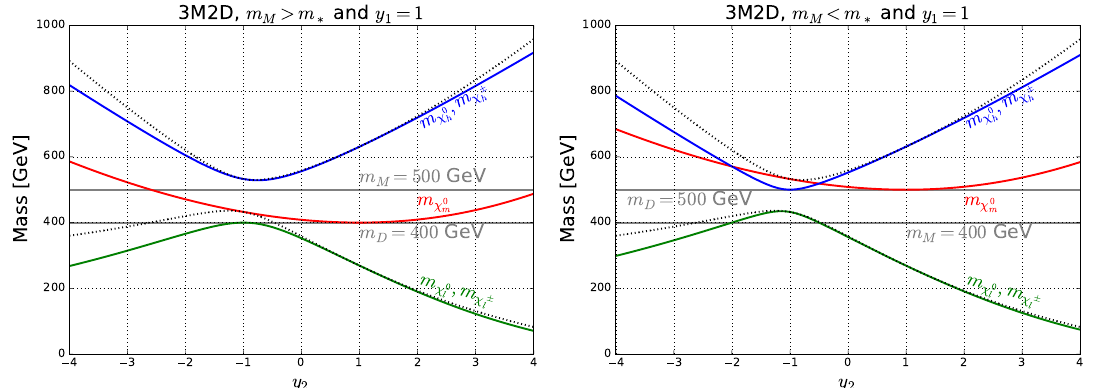
m D 3a and m D m M 3b. (cid:29) (cid:29)